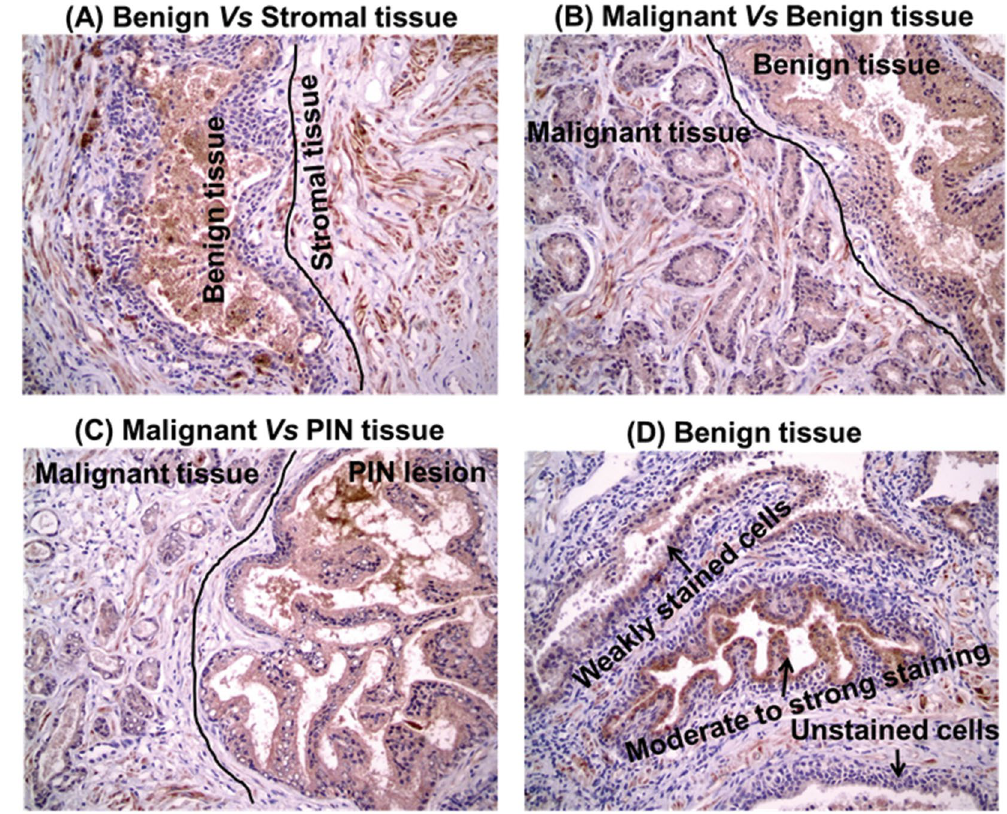
Figure 3. Representative analysis of immunostaining for NLRP3 expression in human prostate archival tissue specimens (n = 19). ( A ) moderate to strong staining in stromal tissues as compared to benign tissue areas; ( B , C ) homogeneous staining among malignant vs benign ( B ) and malignant vs PIN lesions ( C ); and ( D ) heterogeneous expression of NLRP3 protein in benign tissue area showing unstained, weakly stained, and moderate to strongly stained cells as marked by the arrow